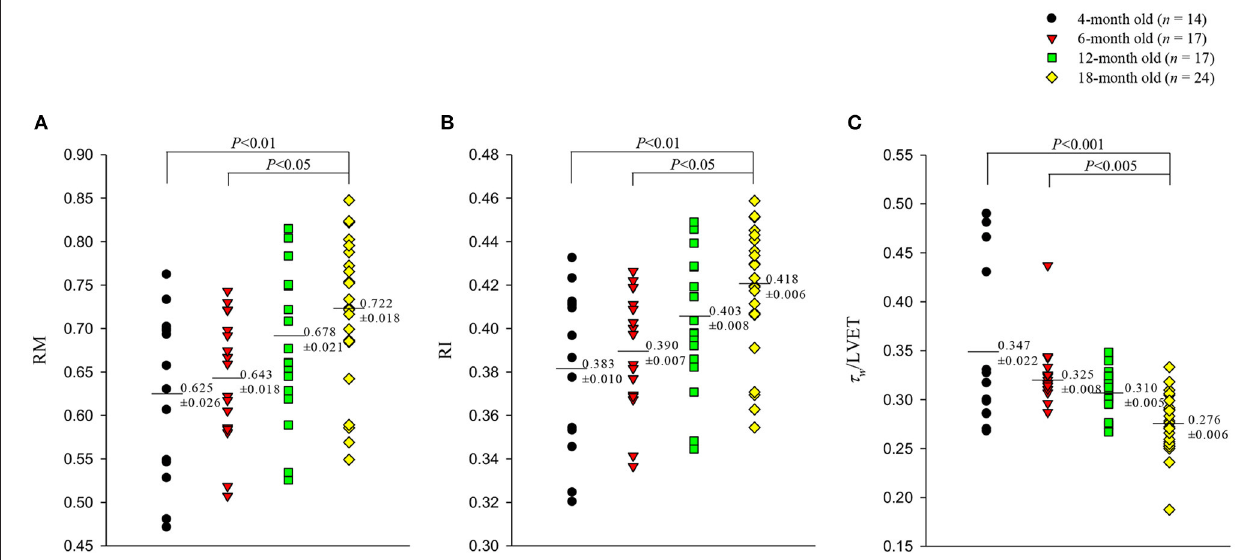
FIGURE 6 | Effects of aging on wave reflection magnitude RM (A) , wave reflection index RI (B) , and the ratio of wave transit time ( τ w ) to left ventricular ejection period (LVET) (C) . The rats aged 18 months had significantly higher RM and RI than did those aged 4 and 6 months. Moreover, the τ w /LVET ratio was markedly lower in the 18-month-old rats than in the 4- and 6-month-old